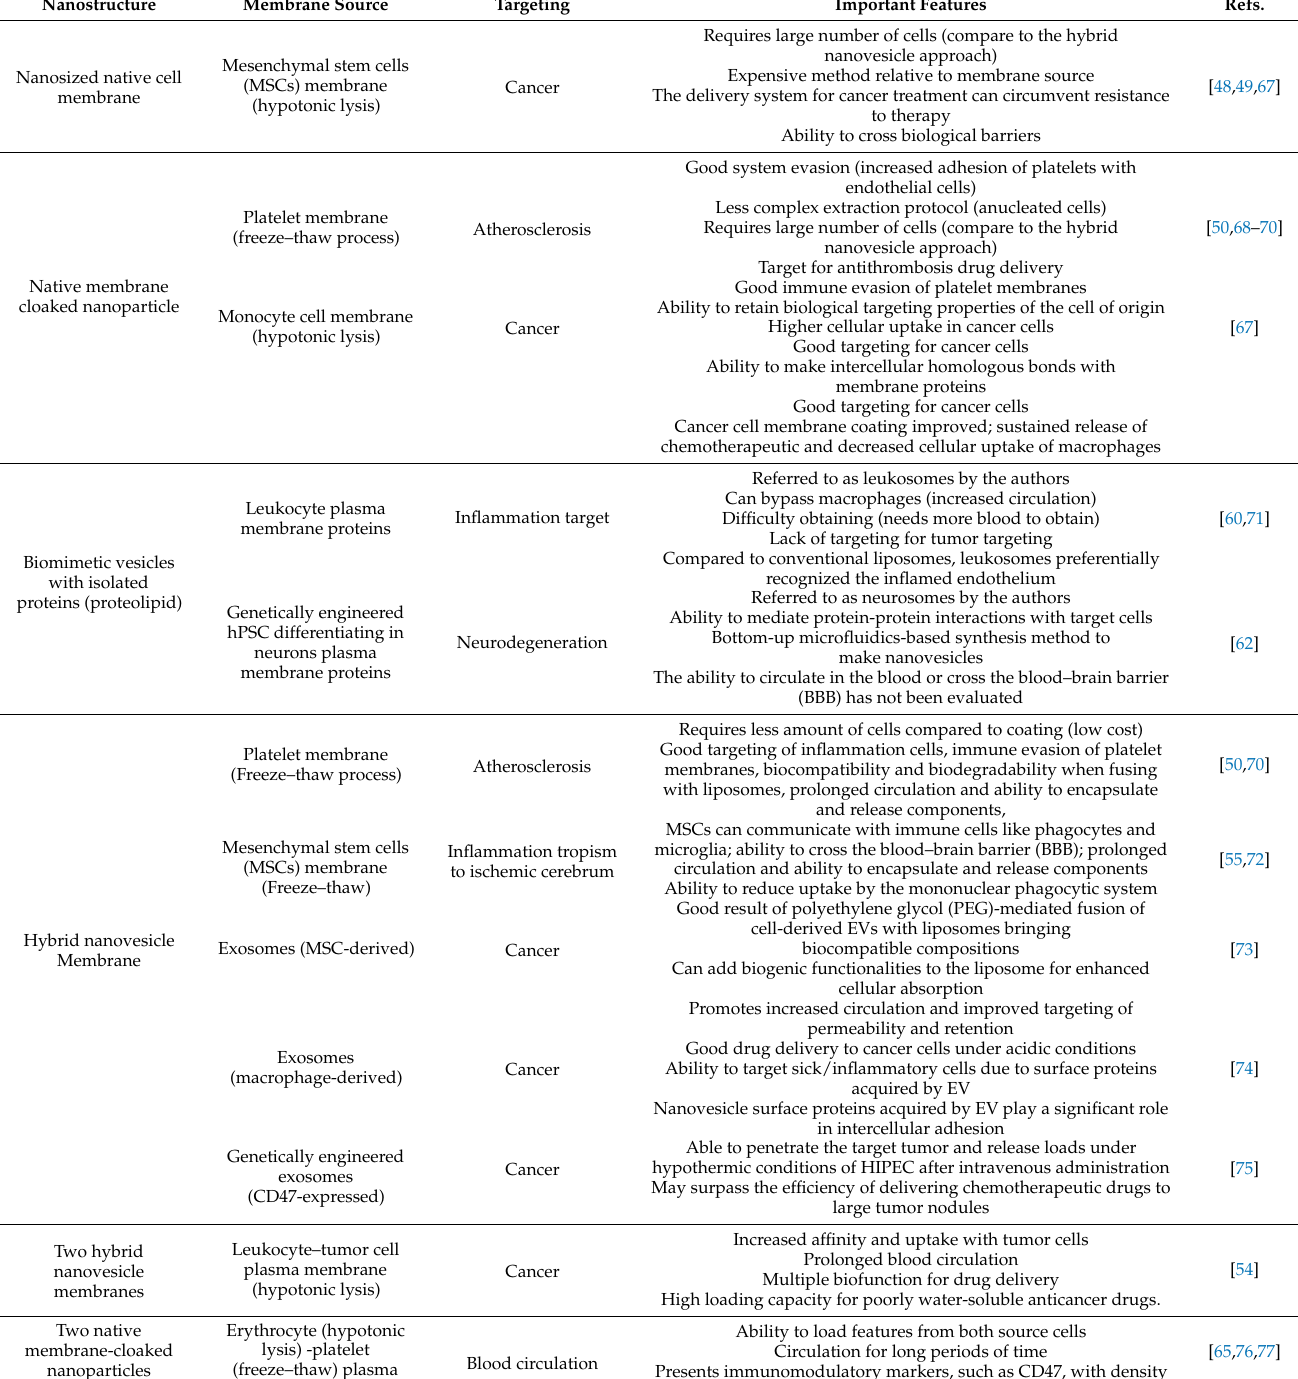
Table 1. Important features regarding the biomimetic nanovesicle